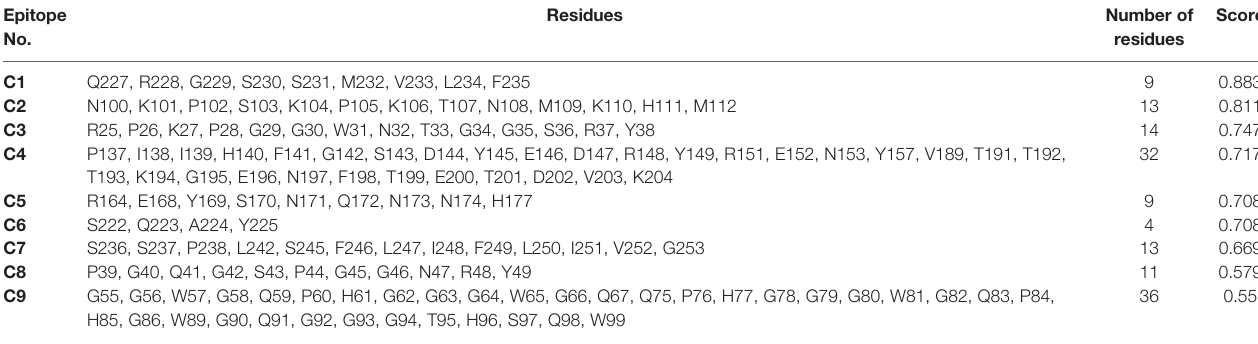
Residues Number of